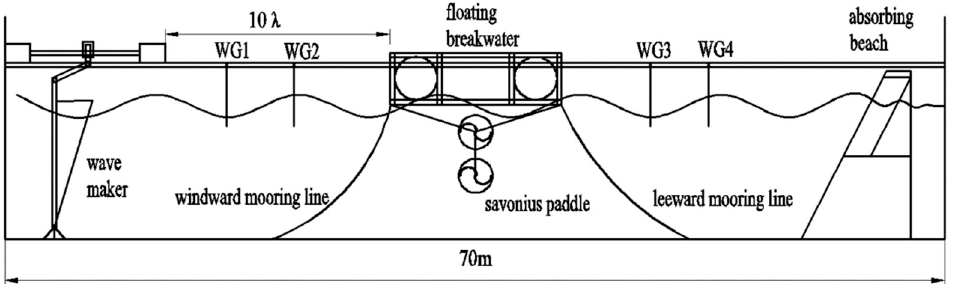
Figure 6. Sketch of floating